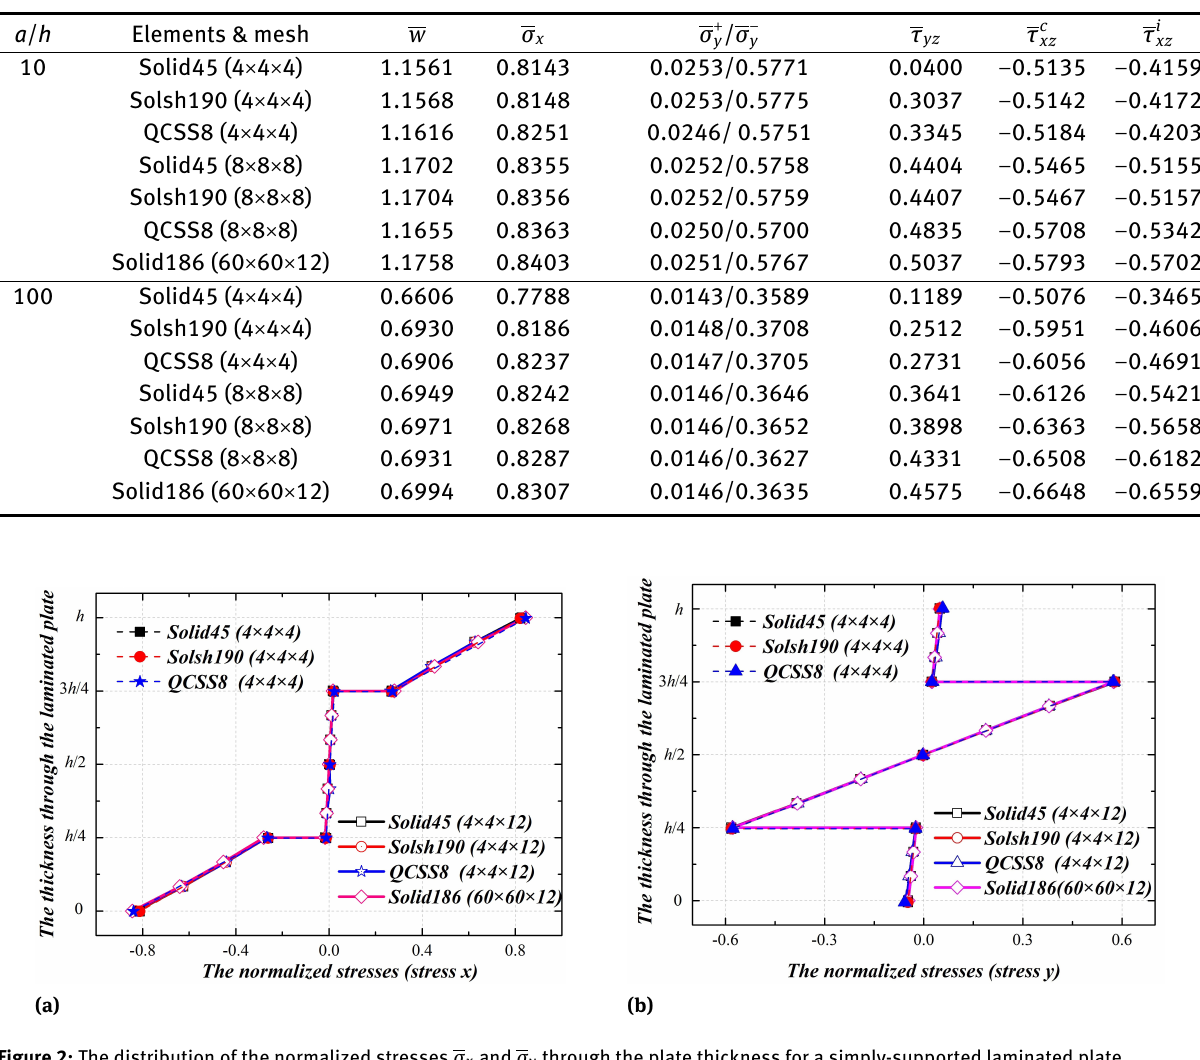
Figure 2: The distribution of the normalized stresses σ x and σ y through the plate thickness for a simply-supported laminated plate [0/90/90/0] subjected to the uniformly distributed load. ( a / h = 10